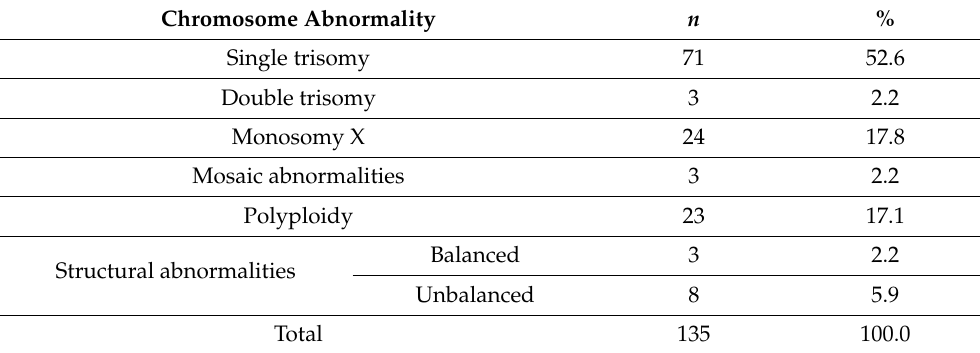
Table 1. Abnormal cases by chromosome abnormality type.